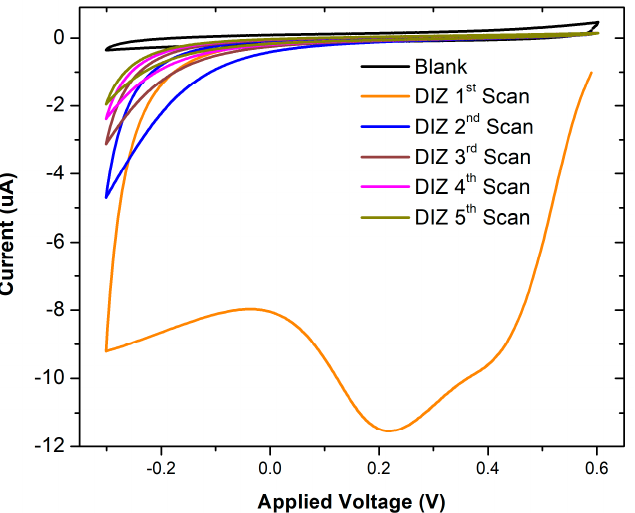
Figure 1. Cyclic voltammograms (50 mV/s) of glassy carbon electrode (GCE) in Bu 4 NBF 4 in ace- tonitrile 0.1 M before (black curve) and after the addition of diazonium (DIZ) (orange curve); after repeated voltammetry cycles (five scans, fifth scan olive green curve), there was no further reduction. The experiment was repeated four times.